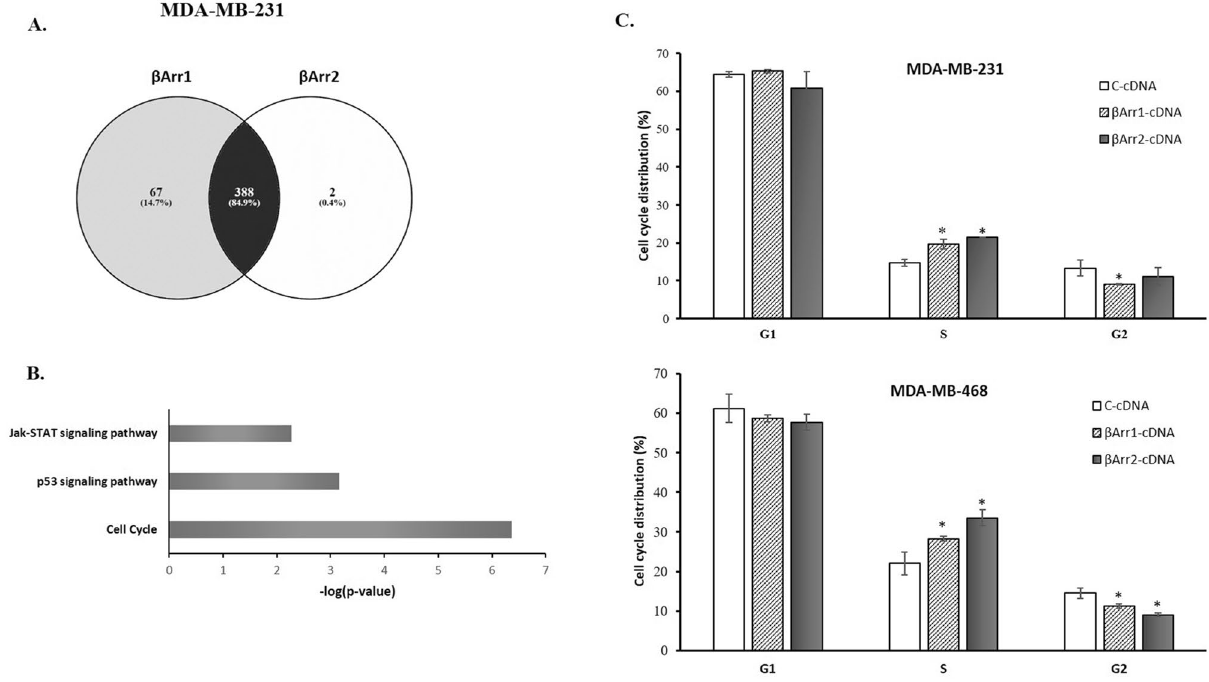
Figure 5. Microarray analysis revealed the cell cycle. Microarray and cell cycle analysis were performed in C (control)-, βArr1-, or βArr2-cDNA transfected MDA-MB-231 cells. Cell cycle analysis was also performed in C (control)-, βArr1-, or βArr2-cDNA transfected MDA-MB-468 cells. ( A ) Microarray data analysis showed that 455 and 390 genes were differentially expressed in βArr1 and βArr2-overexpressed MDA-MB-231 cells respectively compared to control cells. VENNY analysis conducted with differentially expressed genes showed that of these differentially expressed genes, 388 were common to both βArr1 and βArr2 overexpressing MDA-MB-231 cells, including almost all the differentially expressed genes in βArr2 overexpression. ( B ) The pathway enrichment and the KEGG pathway analysis were performed with these differentially expressing genes. These genes were significantly enriched in cancer related pathways, Jak-Stat, p53 signalling pathway and cell cycle genes. ( C ) Cell cycle analysis showed that S-phase cell populations significantly increased following βArr1 and βArr2 overexpression in MDA-MB-231 and MDA-MB468 cells. Eventually, cells in G2-phase decreased in both cell lines. Data are presented as mean ± standard error of the mean; n = 4–5; * = p < 0.05 versus